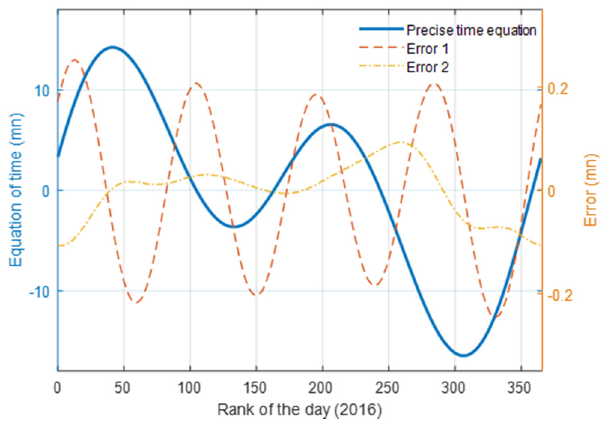
Figure 6. Comparison between expression (12), Equation (13) and IMMCE calculation to choose the time equation.